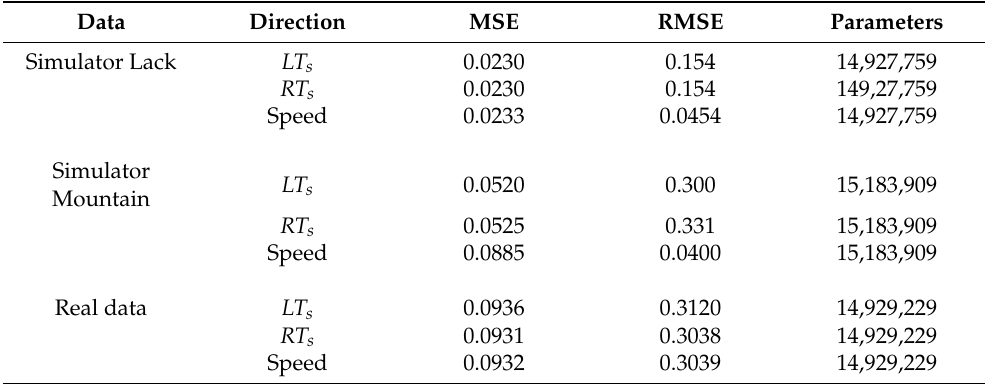
Table 3. Performance analysis of the proposed framework in terms of MSE, RMSE, and number of parameters.